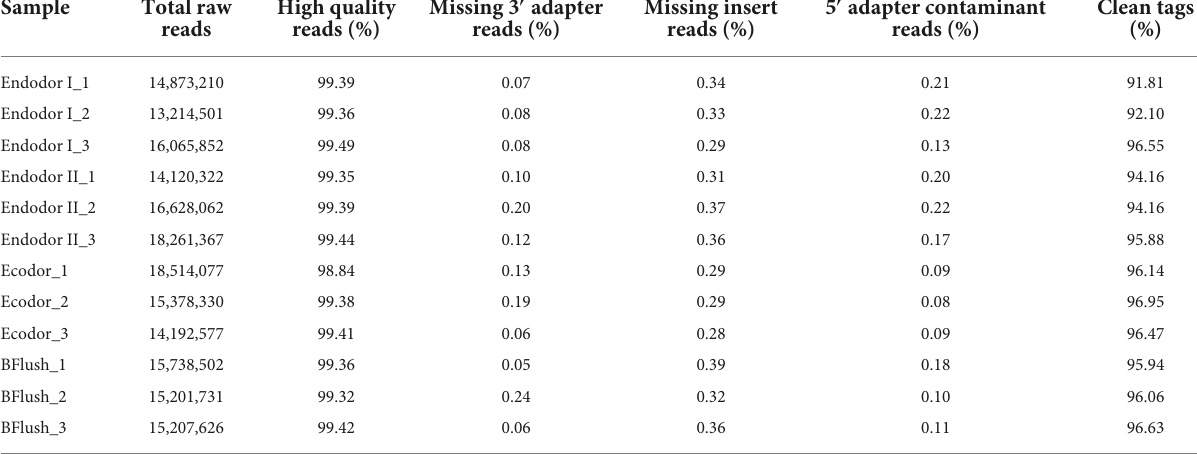
TABLE 2 Summary statistics of sequence reads generated from 12 small RNA sequencing libraries.